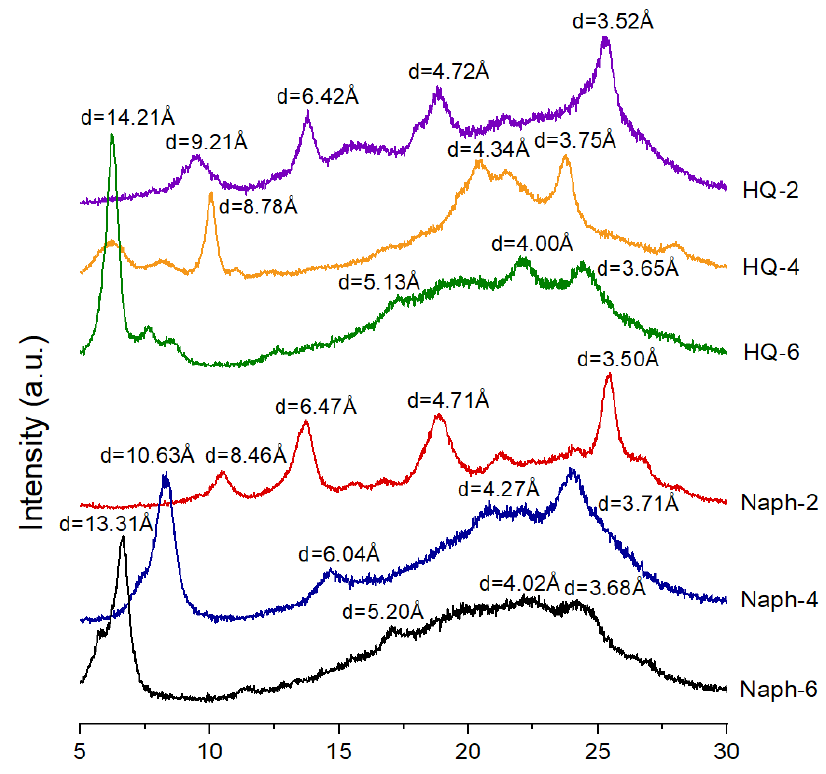
Figure 7. XRD patterns of HQ- and Naph-TLCPs.